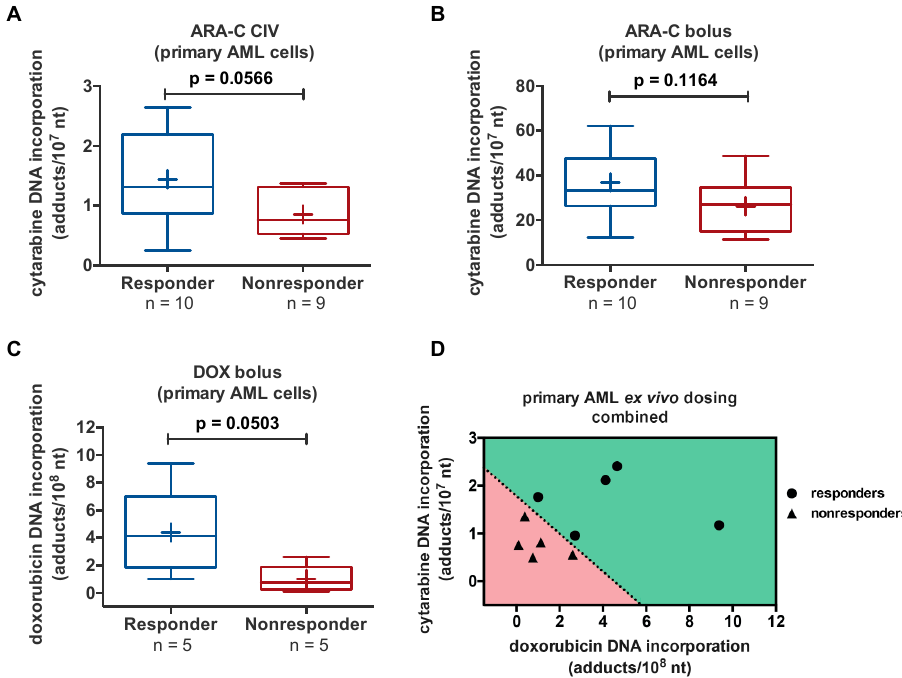
Figure 10. Correlation of ARA-C- and DOX-DNA levels to 7 + 3 response after in vitro dosing of 20 primary AML samples. PBMC were exposed to either exposed to a microdose of [ 14 C]ARA-C or [ 14 C]DOX at ~1% of the approximate plasma C max obtained with ARA-C CIV ( A ), ARA-C bolus ( B ), or DOX bolus ( C ) observed in patients. Cells were dosed for 1 h followed by DNA isolation and AMS